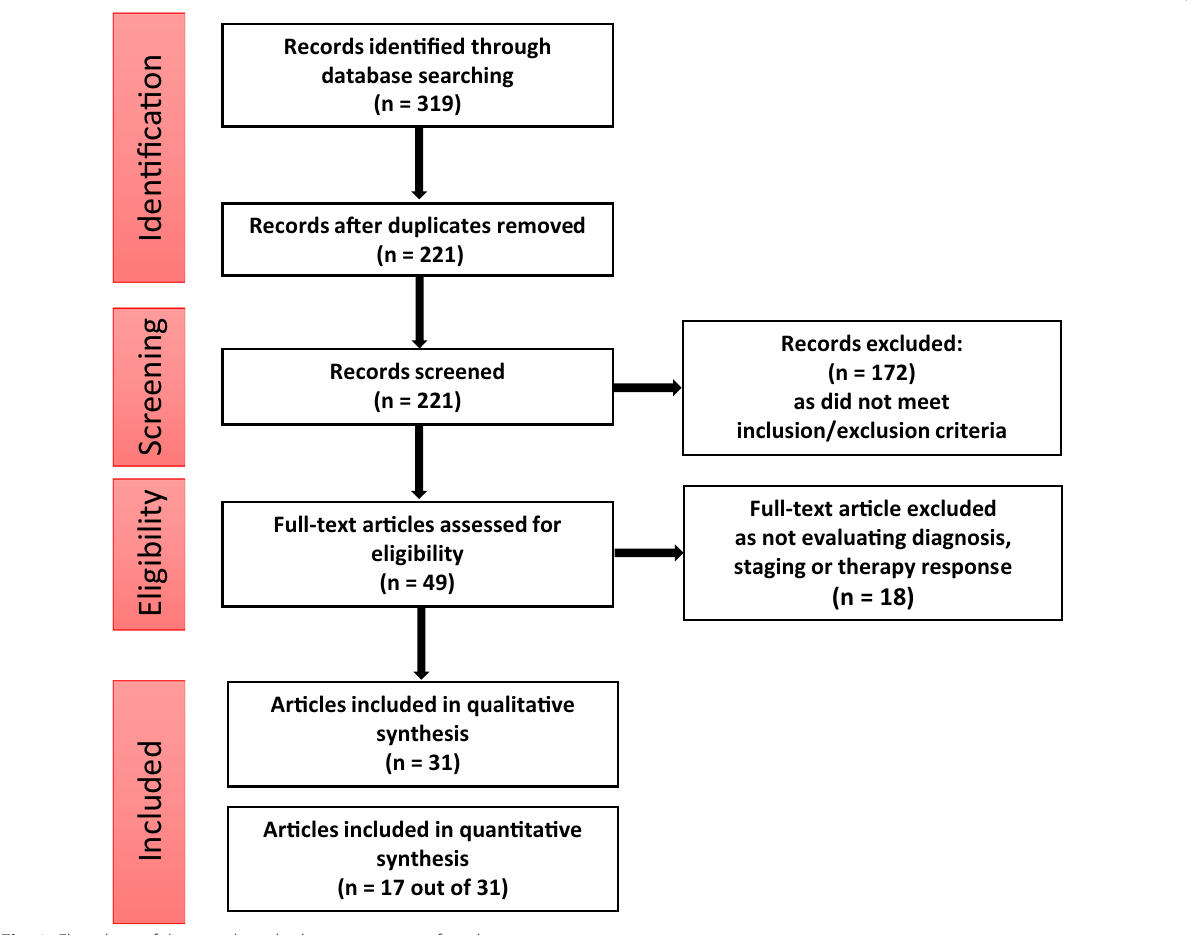
Fig. 2 Flowchart of the search and selection process of